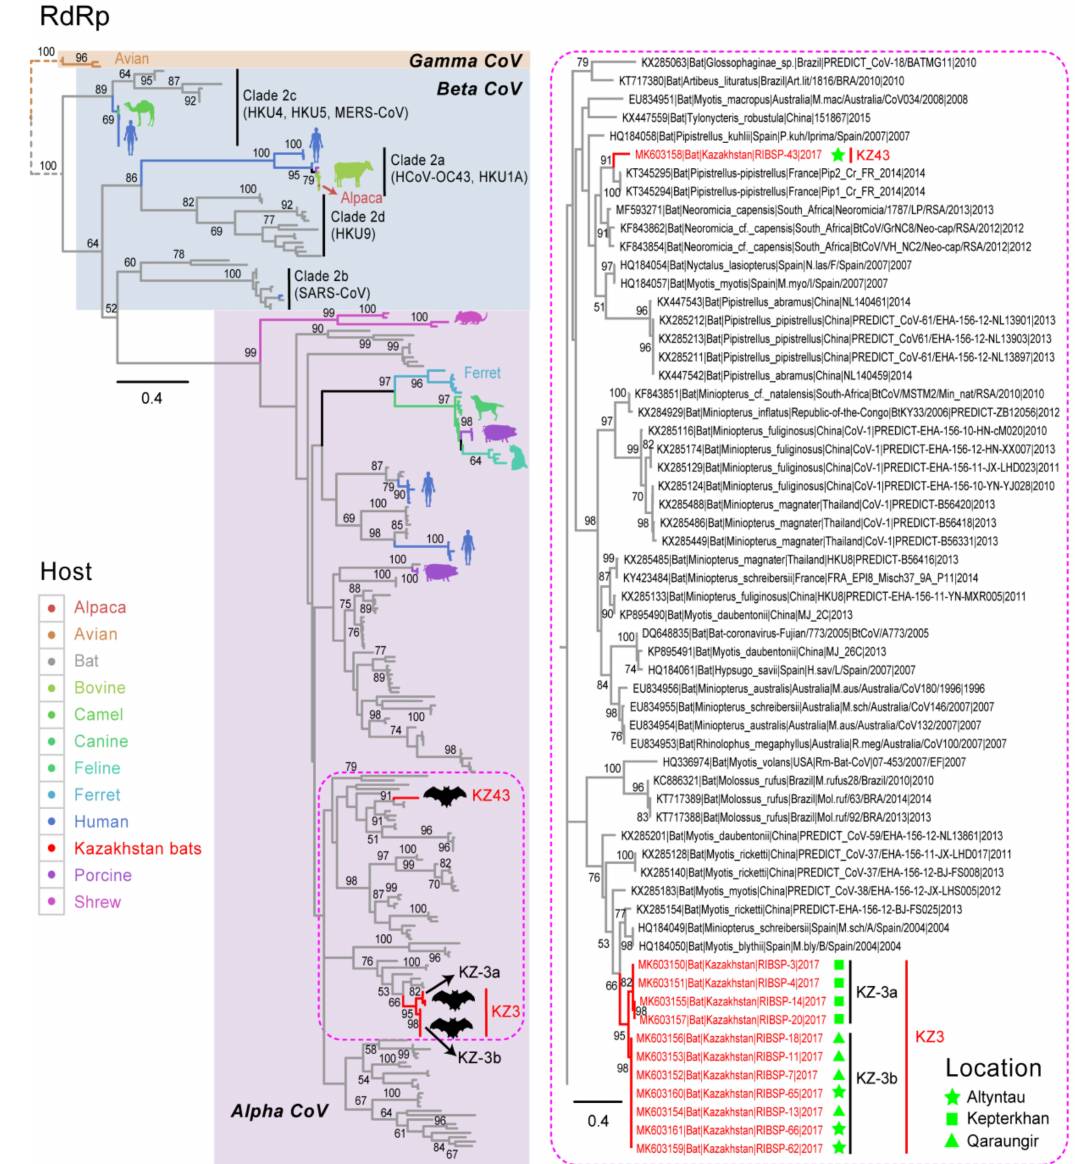
Figure 2. Phylogenetic relationships of the RNA-dependent reverse polymerase (RdRp) gene sequences of coronavirus, inferred using the maximum-likelihood method with the GTR + GAMMA model in RAxML. Representative virus isolates from Alpha -, Beta -, and Gamma - coronavirus (CoV) were included in the analysis. Colored branches and symbols denote viruses collected from di ff erent hosts. New CoV sequences generated from this study are marked by red branches. The dotted box indicates Kazakhstan coronavirus lineages (KZ3 and KZ43) described in this study and their closely related viruses isolated worldwide. The inset displays detailed strain names of the Kazakhstan coronaviruses and their closely related viruses. Cave locations are denoted by di ff erent shapes in green. Bootstrap support values greater than 50% are displayed at major nodes. The scale bar indicates the number of nucleotide substitutions per